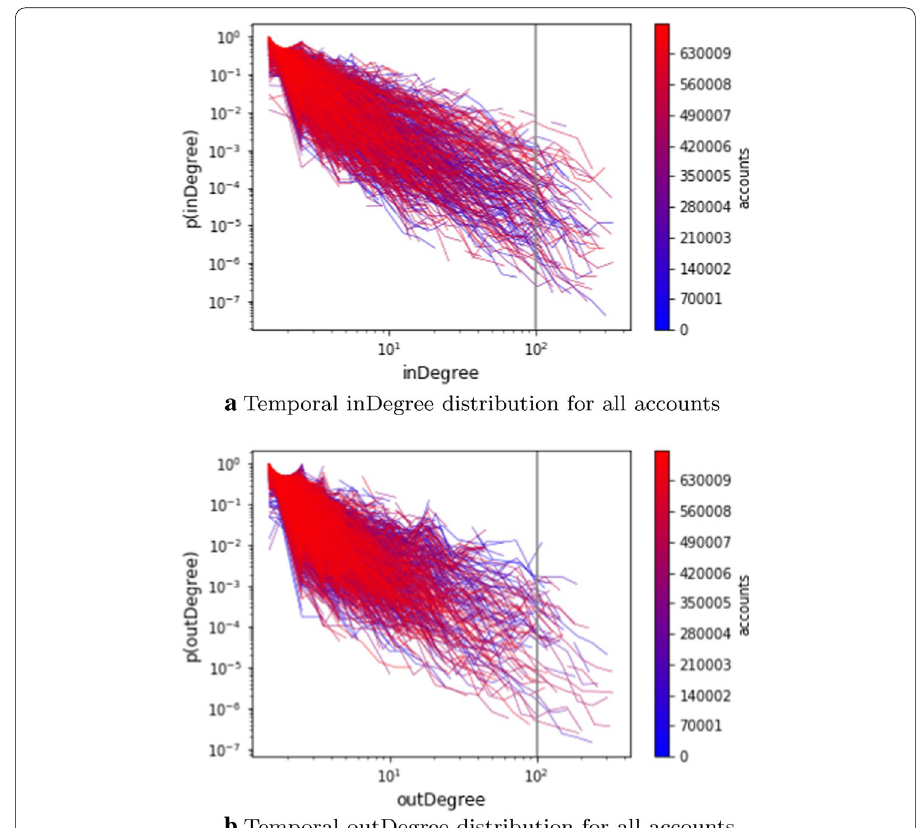
Fig. 6 Temporal degree distribution of individual